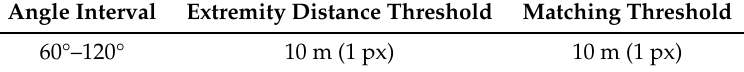
Table 2. Calibration parameters of the corner extraction and corner matching. The angle interval and extremity distance threshold define how a corner is extracted from two segments. The angle formed by the segments must be within the interval and the extremities must be at a distance smaller than the threshold. The matching threshold determines how much tolerance is taken when matching corners from two different classification maps.